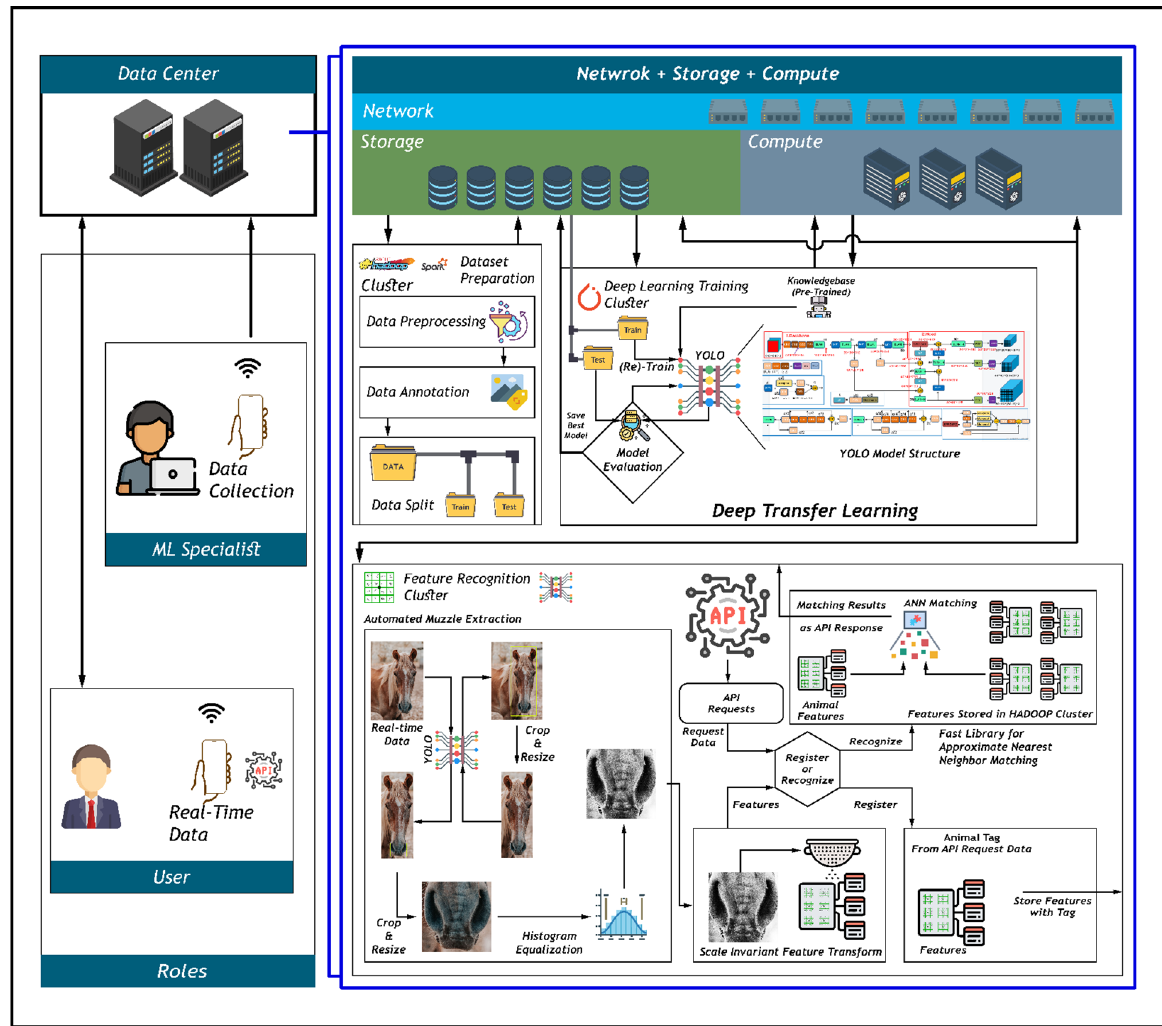
Figure 2. Architecture of Proposed System.